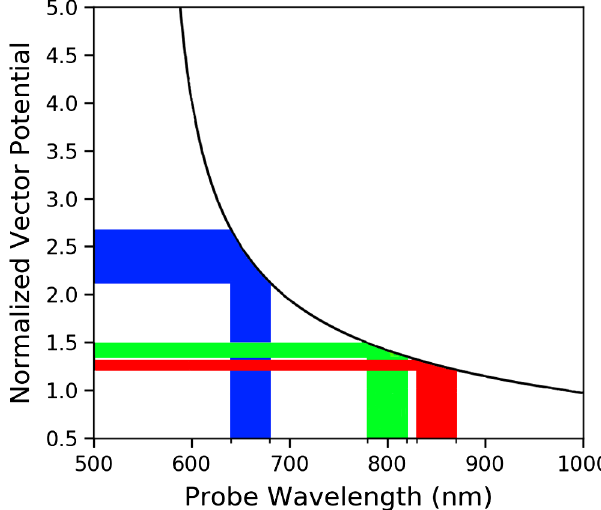
FIG. 3. Spectral dependence of the cyclotron resonance for relativistic pump intensities ( λ L ¼ 800 nm) in underdense plasma. The three colored regions correspond to the three bandpass filters used in the experiment.